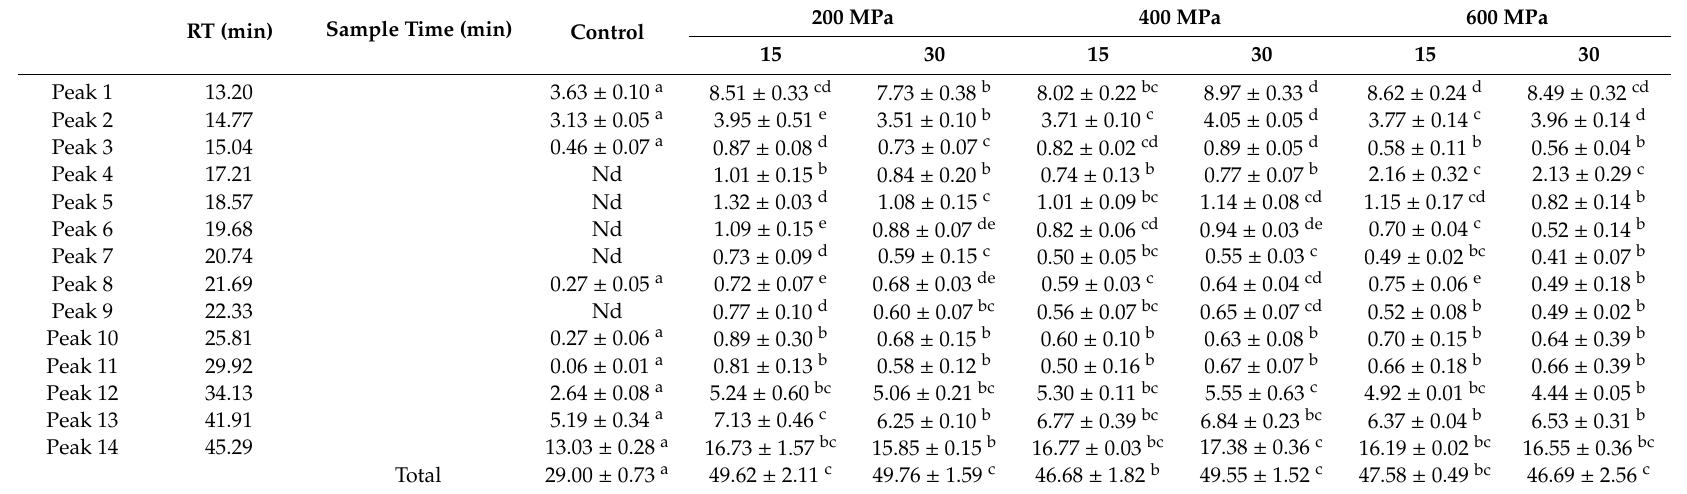
Table 1. HPLC-RID analysis of water-soluble carbohydrates released from apple by-product after HHP treatment assisted by Celluclast ® . RT (min)